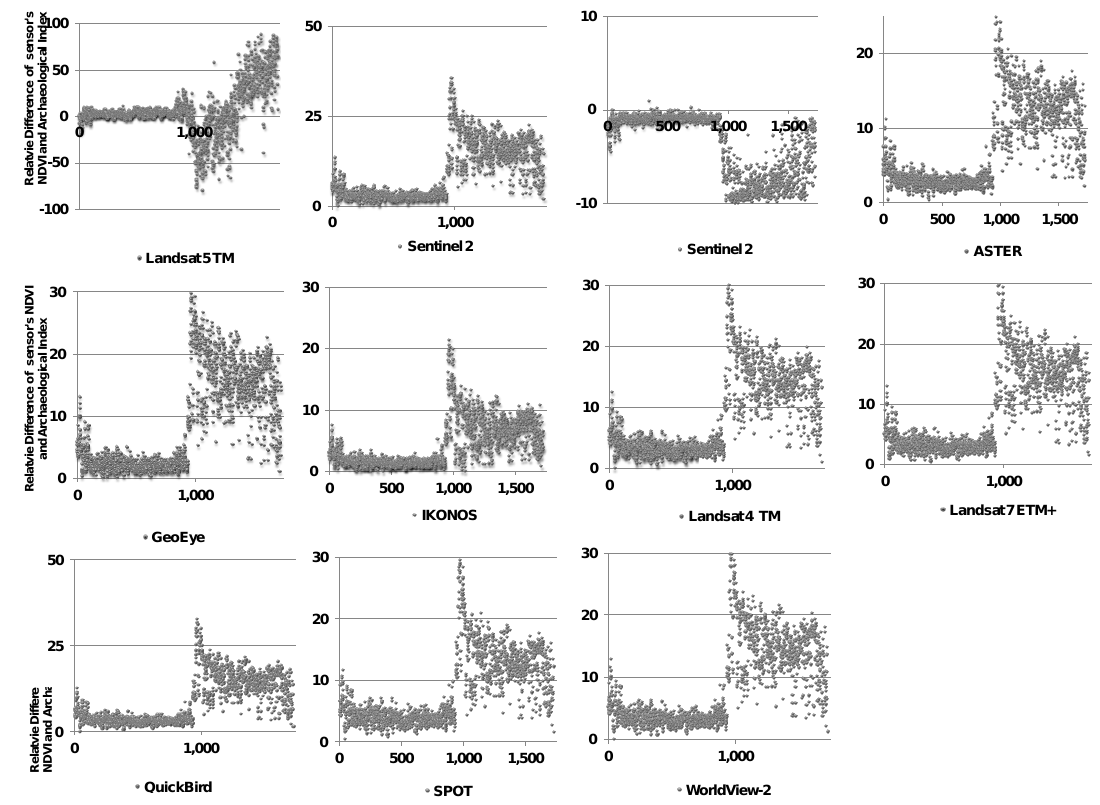
Figure 5. Relative difference (%) of the NDVI values compared with the Normalized Archaeological Index.